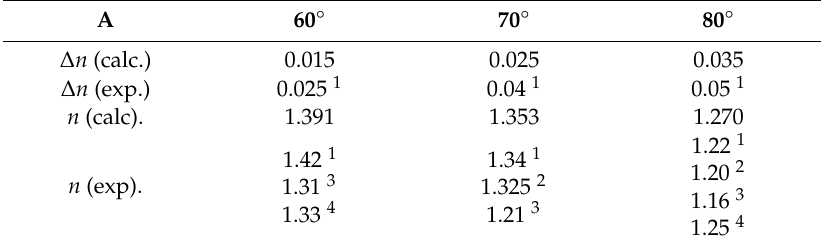
Table 2. Dependencies of the difference between the components of the refractive index ∆ n and